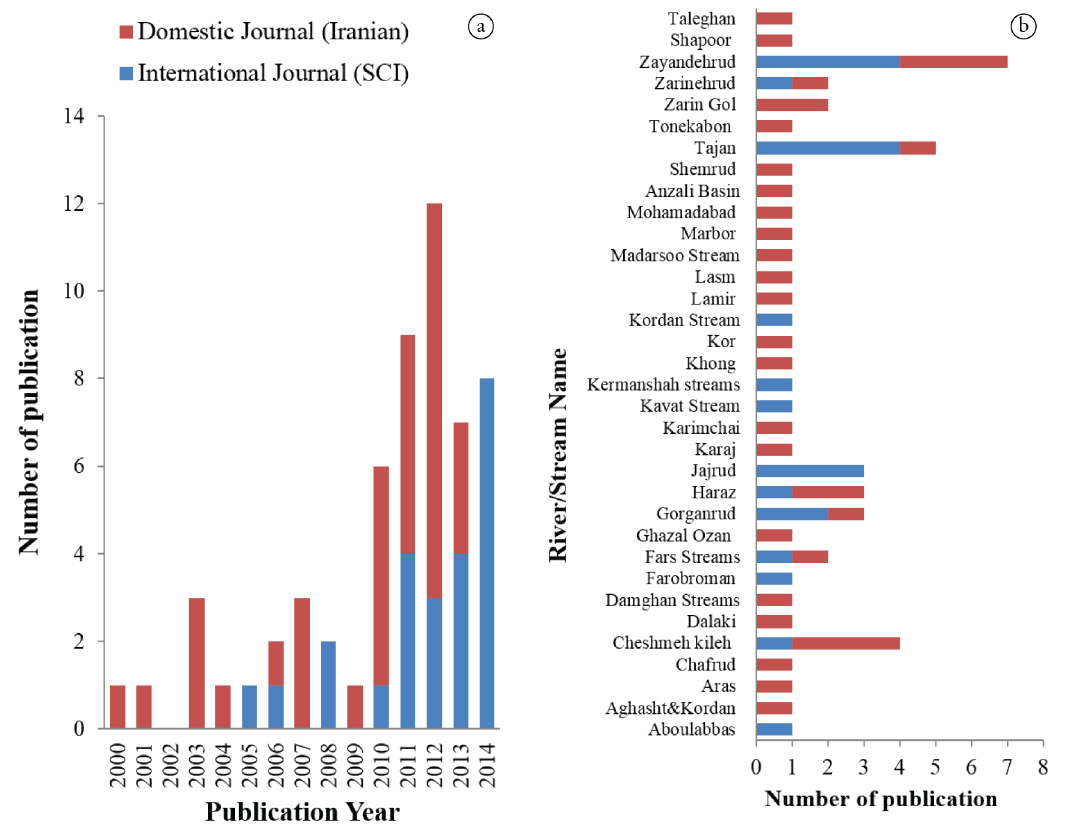
Figure 1. The overview on macroinvertebrate studies conducted at the Iranian running waters; (a) yearly number of publications over the past 15 years, and (b) the number of publications referring to 35 rivers and streams with corresponding references, a total of 57 reviewed articles. References: Abbasi et al. (2013a, b), Abbaspoor et al.